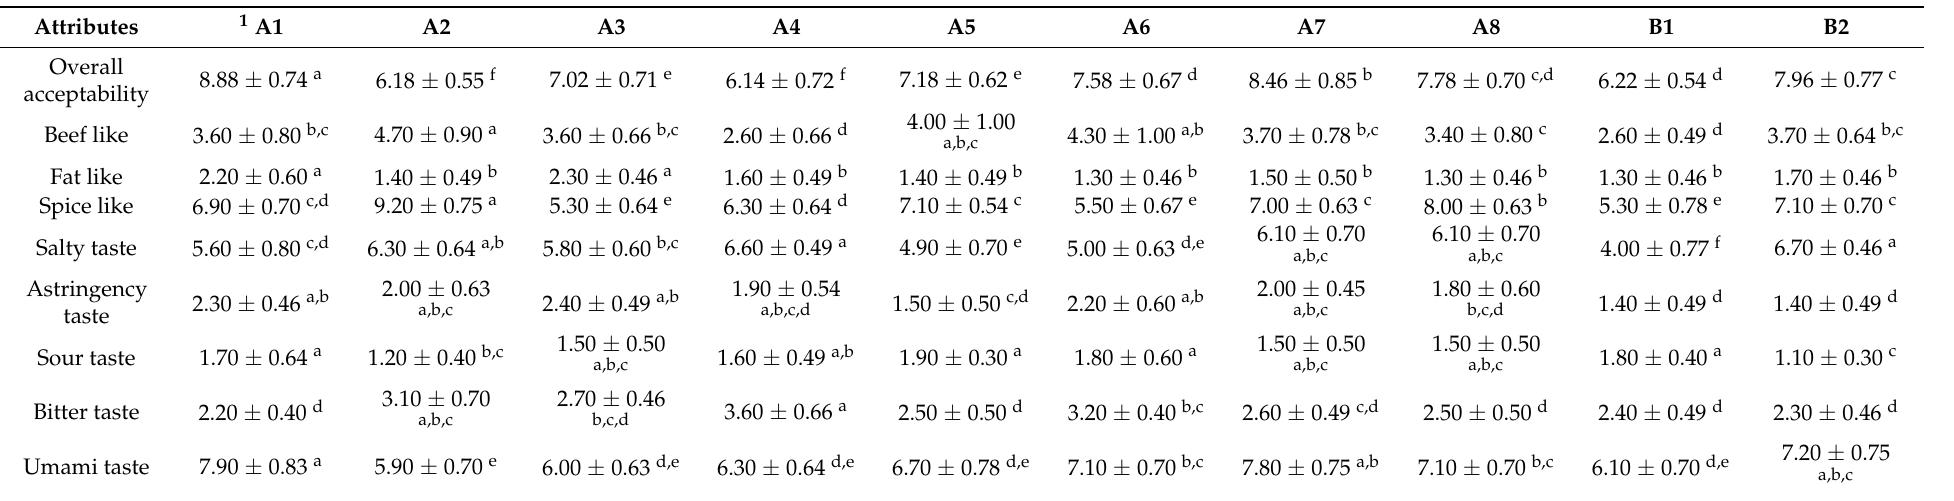
Table 6. Sensory analysis of 10 groups of beef